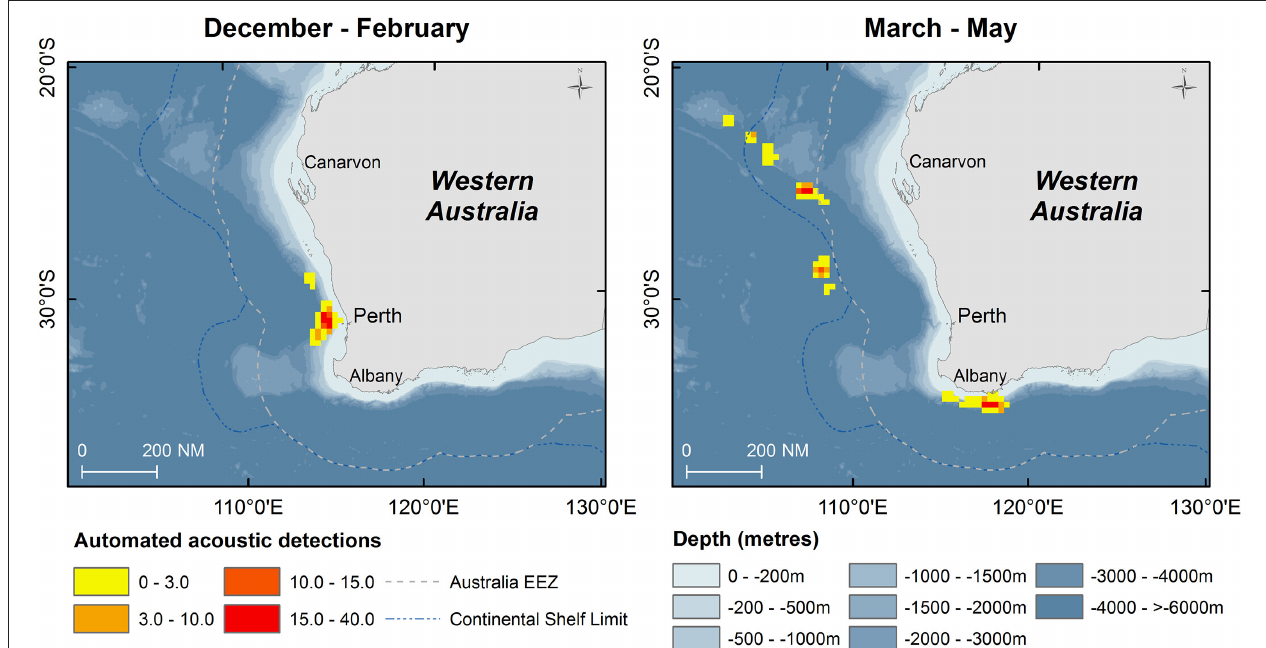
FIGURE 4 | Kernel density of number of automated acoustic detections of sperm whales during the voyage of the RV Odyssey off Western Australia. Data are shown in 15 nautical mile grid cells by season when the vessel was operating in the area.